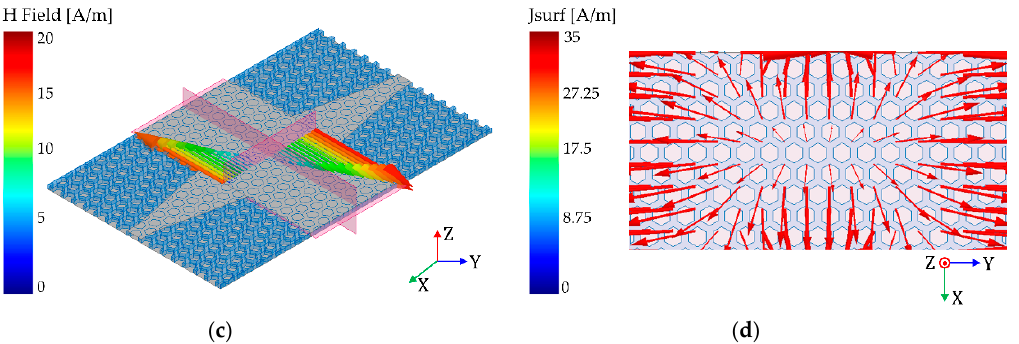
Figure 9. Simulated TE 10 mode SIW field distributions: ( a ) E z on x-y plane; ( b ) H x on y-z plane; ( c ) H y on z-x plane; and ( d ) electrical current on x-y plane at 4 GHz.